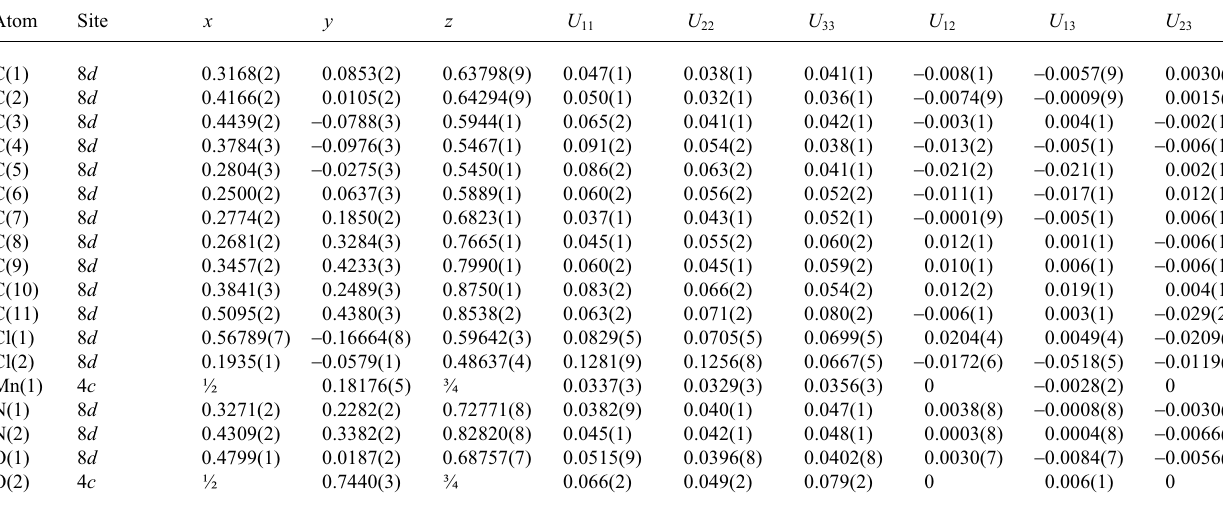
Table 3. Atomic coordinates and displacement parameters (in Å 2